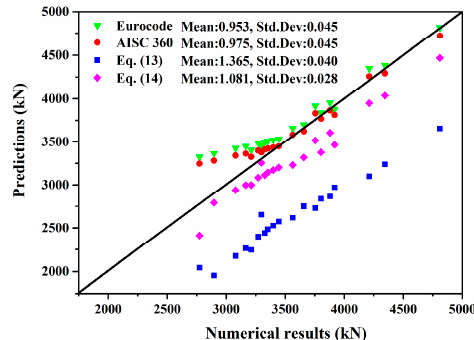
Figure 21. Comparison of numerical results with predicted results.